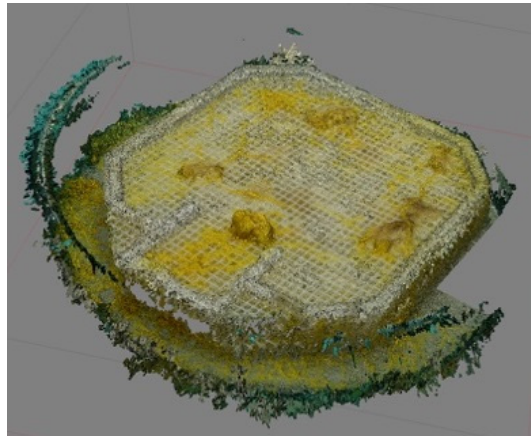
Figure 9. 3D scan of the culture.